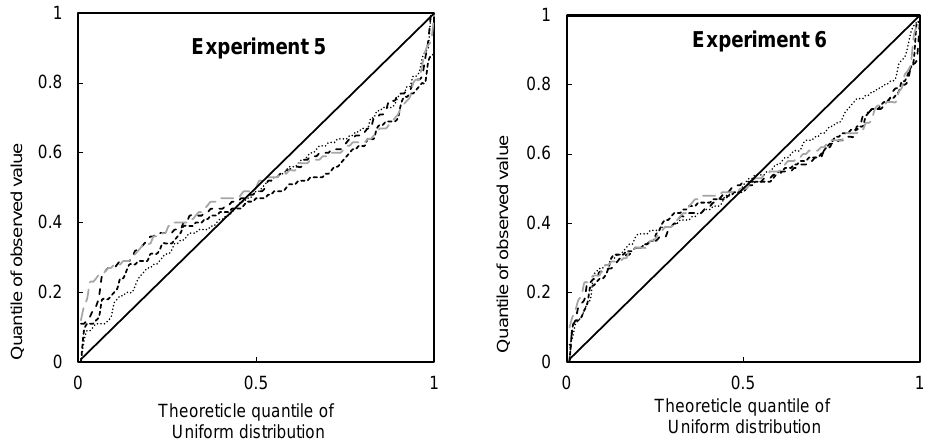
Figure 8. Q-Q plots of the water level prediction for different lead times in different experiments. T indicates the different lead